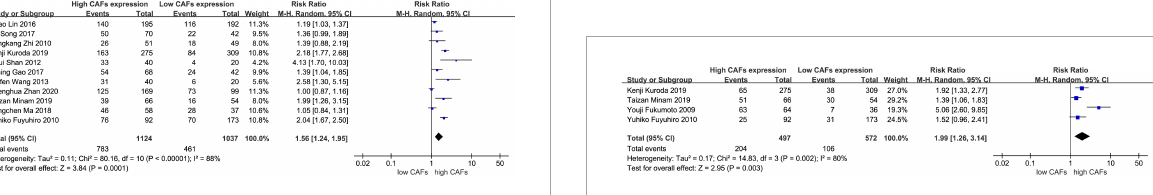
FIGURE 6 High expression of CAFs is associated with vascular invasion in gastric cancer. CAF, cancer-associated fi broblast; CI, con fi dence